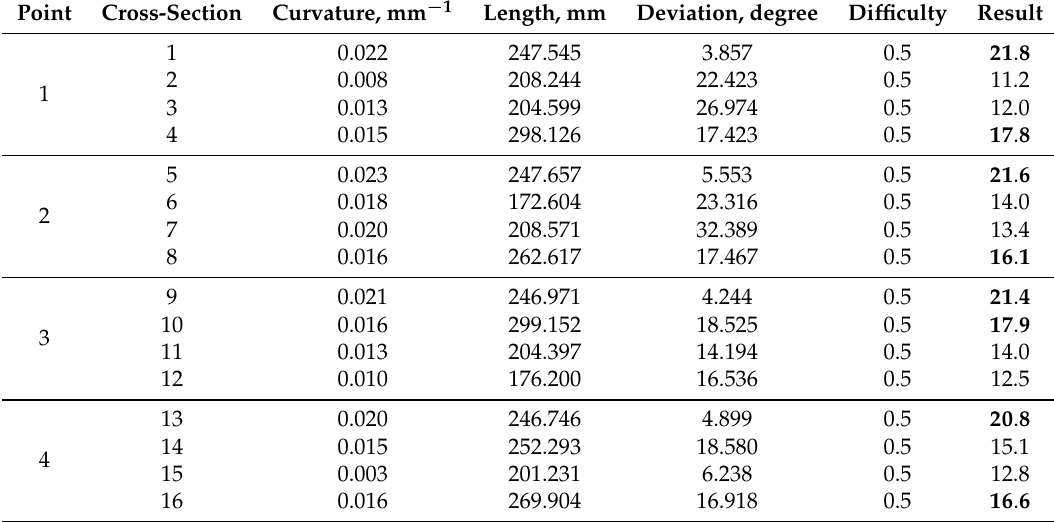
Table 3. The selected results of simulation investigations being the basis for selecting the scanning lines for the first free-form surface.